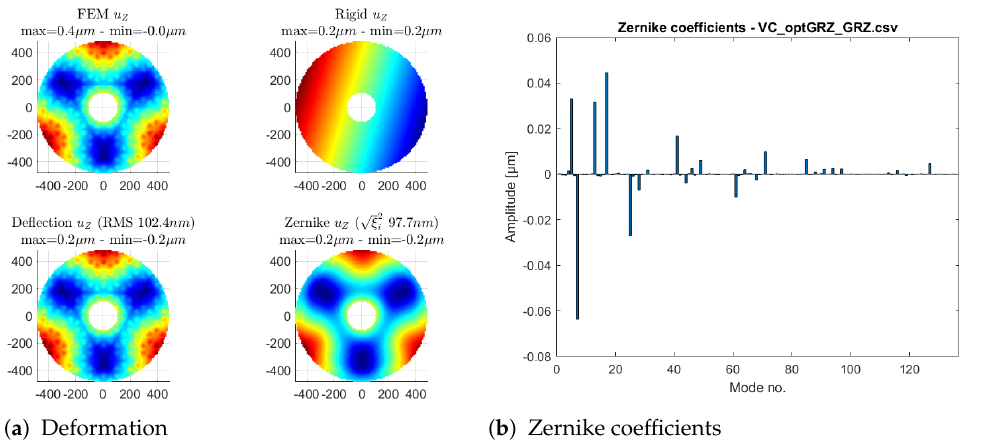
Figure 11. Optimum (optimization conducted on OP responses) and inside